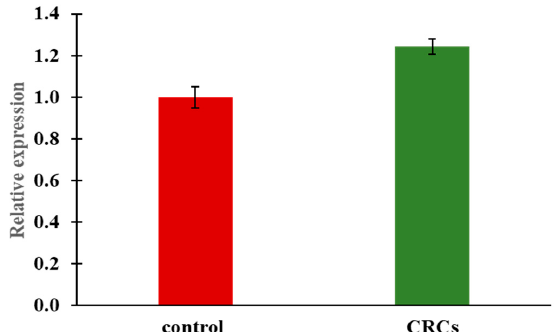
Figure 4. Expression of pck1 following 48h treatment with CRCs at the concentration of 0.2 mg/mL. Pck1 is significantly upregulated compared to the control treated embryos whose gene expression was set as 1. mRNA expression was normalized against ef1a . Data are mean +/ − standard error of the mean (SEM), n = 3, p < 0.0001.